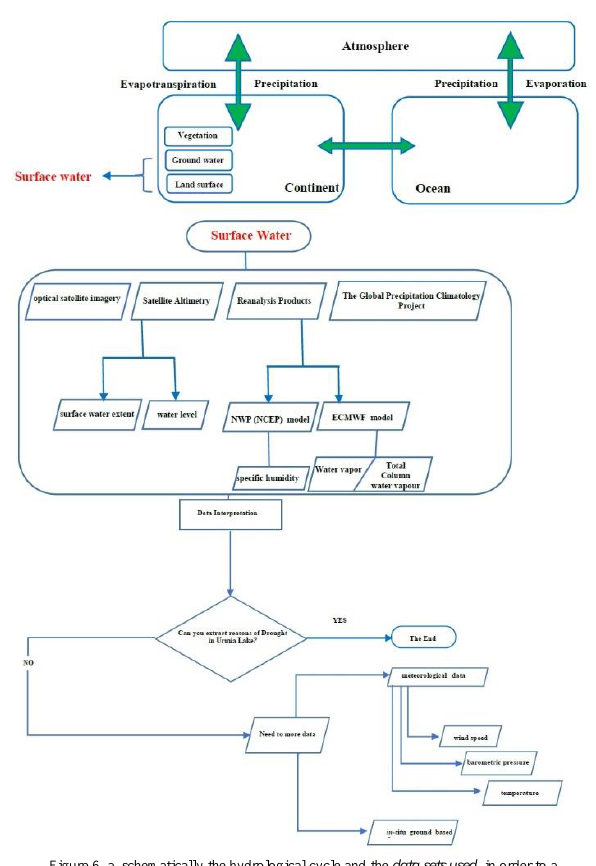
Figure 6. a schematically the hydrological cycle and the data sets used in order to a investigation on changes of Urmia Lake water